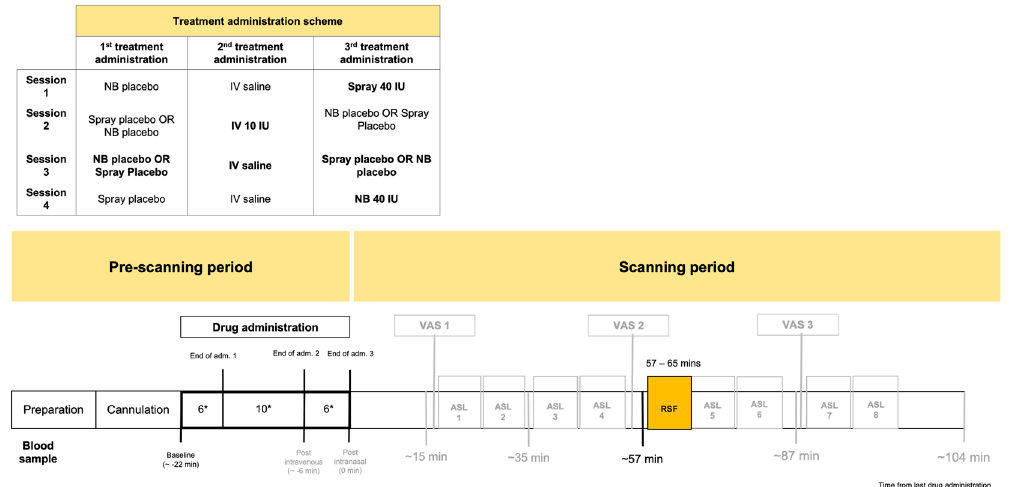
Fig. 8 Study design, drug administration and blood sampling procedures. (NB Nebuliser, IV Intravenous, PLC Placebo, pK Pharmacokinetics, RSF Resting- state BOLD-fMRI, VAS Visual Analog Scale). Upper panel — Drug allocation scheme: In each session, participants received treatment via all three administration routes, in one of two fi xed sequences: either nebuliser/intravenous infusion/standard nasal spray, or standard nasal spray/intravenous infusion/nebuliser. In three out of four sessions only one route of administration contained the active drug; in the fourth session, all routes delivered placebo or saline. Unbeknown to the participants, the fi rst treatment administration method in each session always contained placebo, while intranasal (spray or nebuliser) oxytocin was only delivered with the third treatment administration. The second administration was an infusion of either saline or oxytocin. Lower panel — Study protocol: After drug administration, participants were guided to the MRI scanner, where eight pulsed continuous arterial spin labelling scans (results reported elsewhere 11 ) and one resting-state BOLD-fMRI (RSF) were acquired, spanning 15 – 104 min after last drug administration offset. We assessed participants ’ levels of alertness and excitement using visual analogue scales (VAS) at three different timepoints during the scanning session to evaluate subjective drug effects across time (results reported elsewhere 11 ). Intranasal administrations lasted for about 6 min, while the intravenous administration occurred at the highest rate of 1IU/min for 10 min. We collected plasma samples at baseline and at fi ve timepoints post-dosing to measure changes in the concentration of oxytocin. The resting-state BOLD-fMRI scan used in this study was acquired between 57 – 65 min post last drug administration offset (the end of our second intranasal administration was considered time = 0). *Duration of treatment administration in